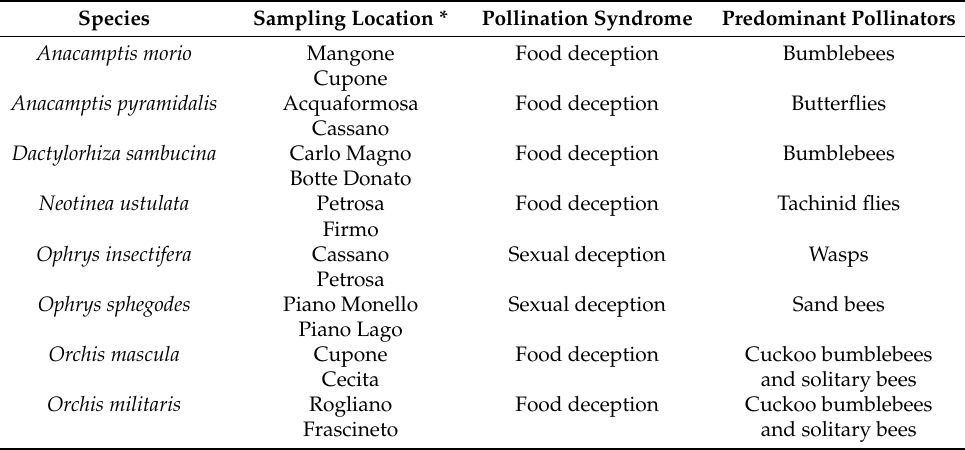
Table 3. Sampling locations, pollination syndromes and predominant pollinators of the studied orchid species. Species Sampling Location